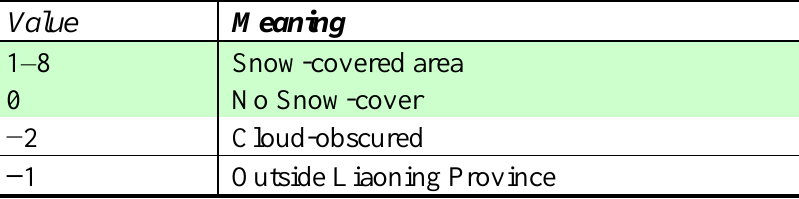
Table 3. Interpretation key for 8-day snow cover mapping derived from MODIS L1B.